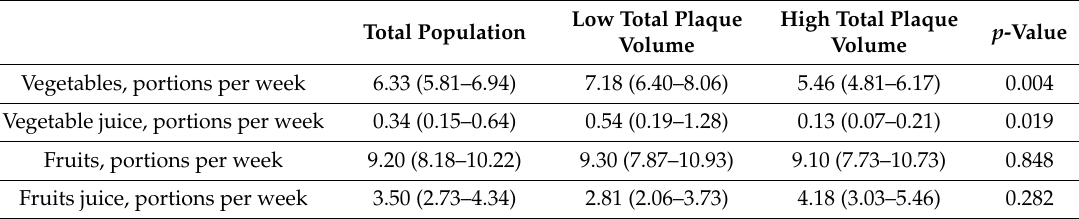
Table 2. Distribution of total plaque volume depending on the consumption of vegetables and fruits.